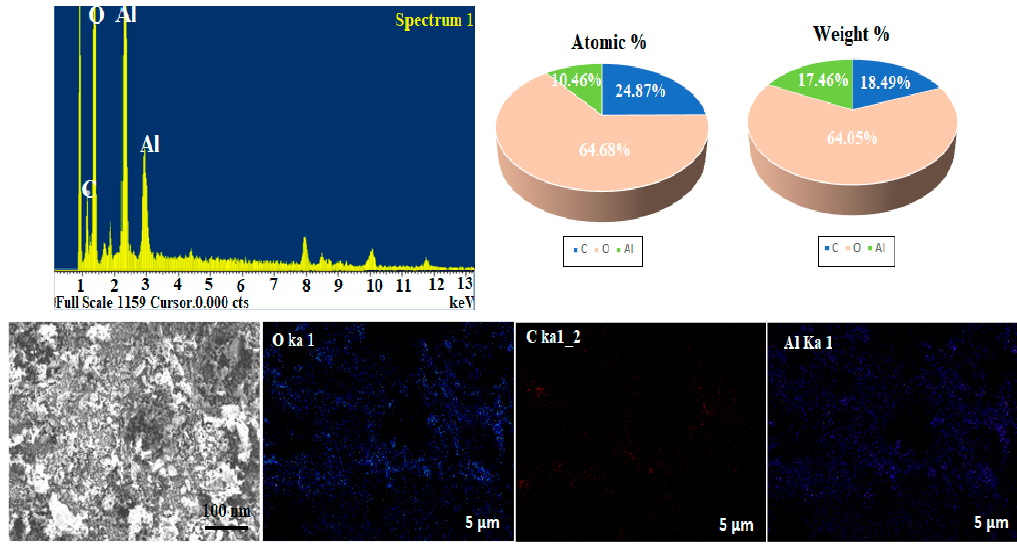
Figure 4. EDX and mapping of Al 2 O 3 NPs synthesized using Lavandula spica flower extract.